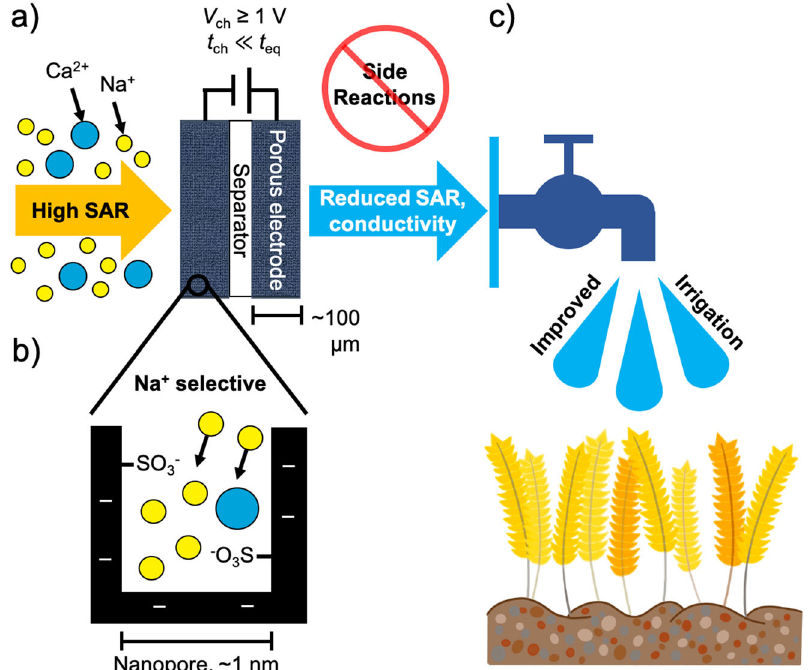
Fig. 1 CDI concept for agricultural irrigation water treatment. a Schematic of a CDI cell fed with water containing excessive Na + which must be treated for direct use in irrigation. The cell is charged at an applied cell voltage V ch at or above 1 V and for a time t ch signi fi cantly shorter than the time to reach equilibrium, t eq . b The cathode nanopore is functionalized with strong-acid sulfonic groups, which enhances the preferential storage of monovalent Na + over divalent Ca 2 + at short charging times. Use of stable sulfonic (SO 3 − ) groups and charging to short times minimizes Faradaic side reactions and thus electrode degradation. c The treated water has signi fi cantly reduced sodium absorption ratio (SAR) and ionic conductivity, rendering it suitable for direct use in